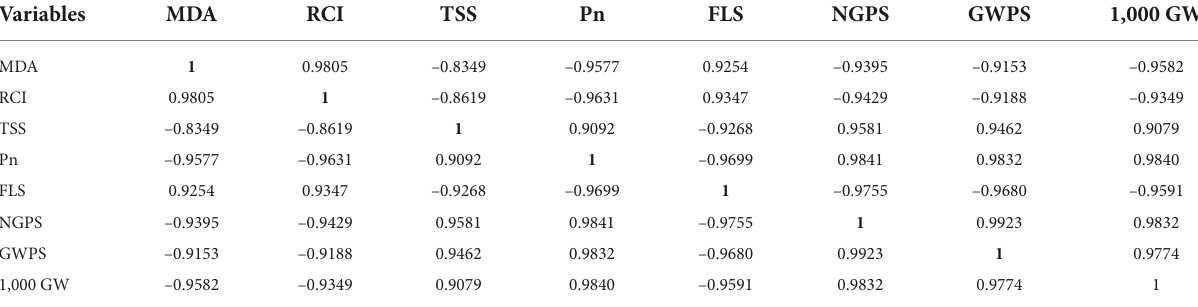
TABLE 4 Correlation matrix of malodialdehyde (MDA), relative cell injury (RCI), total soluble sugars (TSS), net photosynthetic rate (Pn), flag leaf senescence (FLS), number of grains per spike (NGPS), grain weight per spike (GWPS), and 1,000 grain weight (1,000 GW).